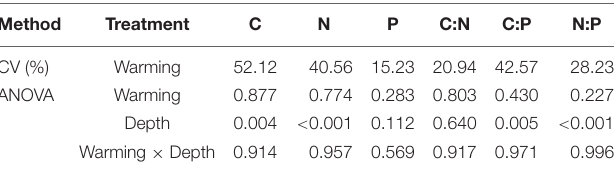
TABLE 3 | Effects of warming and depth on the soil stoichiometric characteristics with organic carbon (C), total nitrogen (N), and total phosphorus (P) in an alpine meadow.